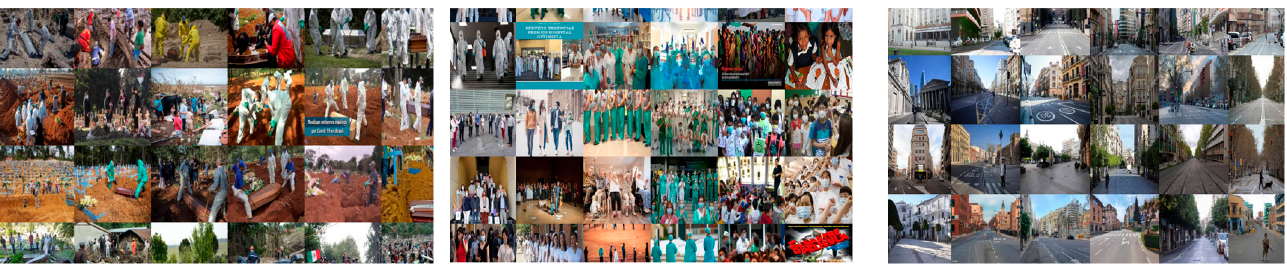
Figure 12. Images representative of each cluster. Figure 12. Digital image containing 10,000 images regarding COVID-19 pandemic (2 × 2 m). © Pilar Rosado.